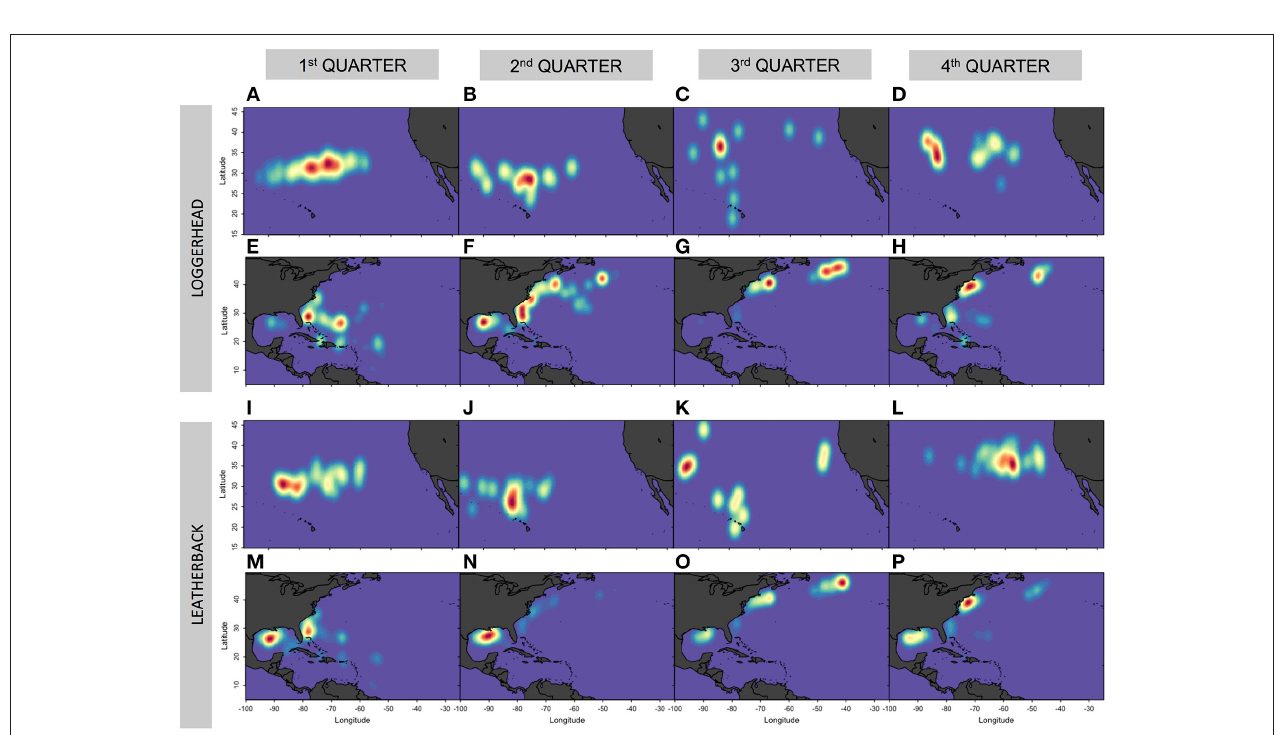
Frontiers in Marine Science |